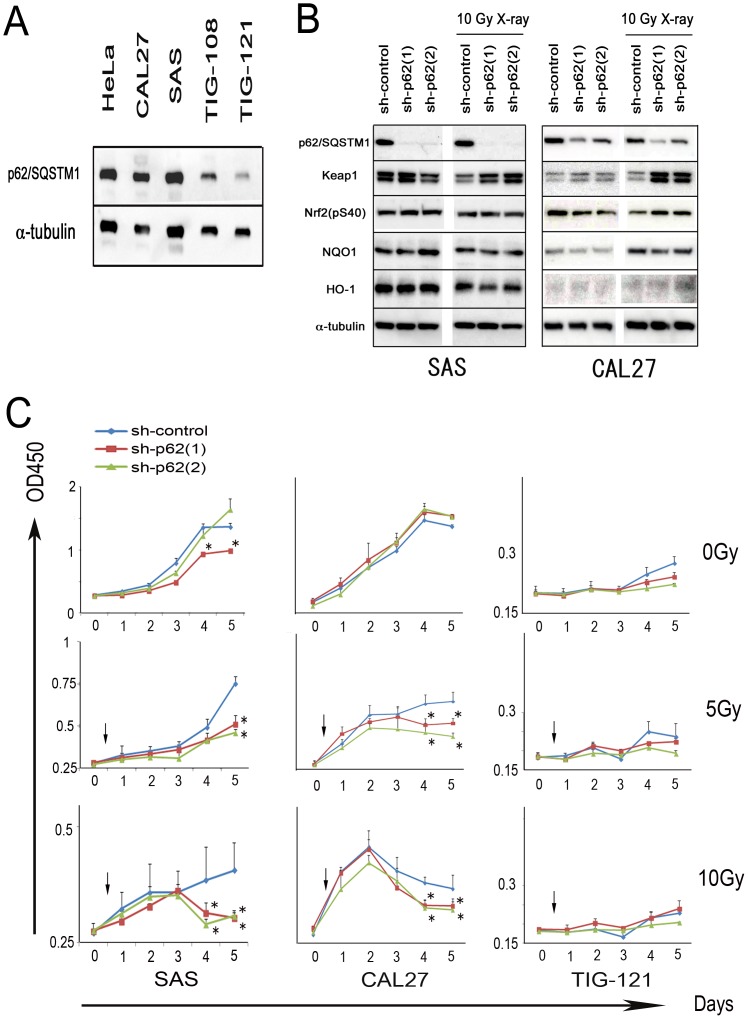
p62/SQSTM1 knockdown had little effect on the Nrf2-NQO1 pathway in oral cancer cells.However, p62/SQSTM1 knockdown affected the growth of the cells. (A) p62/SQSTM1 was abundantly expressed in SAS and CAL27 oral cancer cells. HeLa, endocervical carcinoma cells; TIG-108 and 121, normal human fibroblasts. (B) p62/SQSTM1 knockdown was performed by two kinds of shRNAs (sh-p62(1) and sh-p62(2)). shRNA for luciferase was used as control knockdown (sh-control). p62/SQSTM1 expression was significantly decreased by sh-p62(1) and sh-p62(2). Under no irradiation or 10 Gy X-ray irradiation, expressions of Nrf2 (pS40), Keap1, NQO1 and HO-1 were subtly affected by p62/SQSTM1 knockdown. Similar amounts of each cell protein were loaded in each lane of the SDS-PAGE. α-tubulin was used a loading control. Left and right panels indicate the data on SAS and CAL27, respectively. Three independent experiments were repeated, and the blotting photographs are representative ones. (C) p62/SQSTM1 knockdowns and X-ray irradiation were similarly performed. No radiation (upper); The effects of shRNA (sh-p62(1) and sh-p62(2)) were partial under normal culture condition. X-ray irradiations of 5 Gy (middle) and 10 Gy (lower); The cancer cell growth was significantly inhibited by two kinds of shRNA for p62/SQSTM1. Left and middle panels indicate the data on SAS and CAL27, respectively. The data on TIG-121 are displayed as a reference at the right panels. In the WST-8 assays, mean absorbance values (OD450) ± SE are shown vertically, and the number of days after exposure to radiation is indicated horizontally. The values are derived from quadruplicate experiments (*, p<0.05, one-way factorial ANOVA and multiple comparison tests accompanied by Scheffe's significance test).